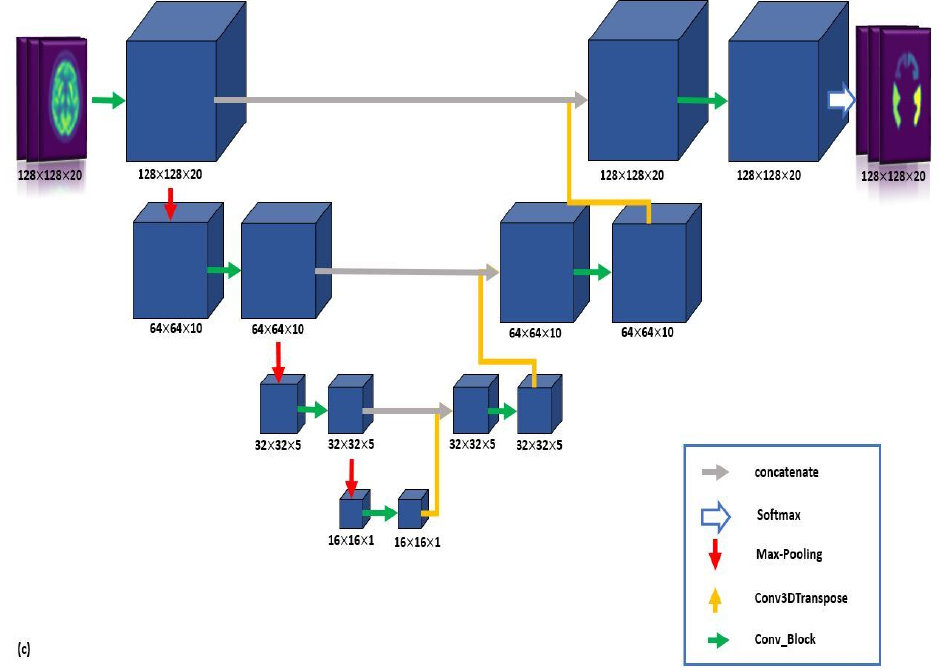
Figure 2. U-Net3D architectures: ( a ) U-Net3D; ( b ) U-Net3D-NoMaxPoolingThirdDimension; ( c ) U-Net3D-TwoLevel. The arrows correspond to operations or functions applied to the images; the blue cubes are the image volumes; numbers under the cubes are volume sizes.